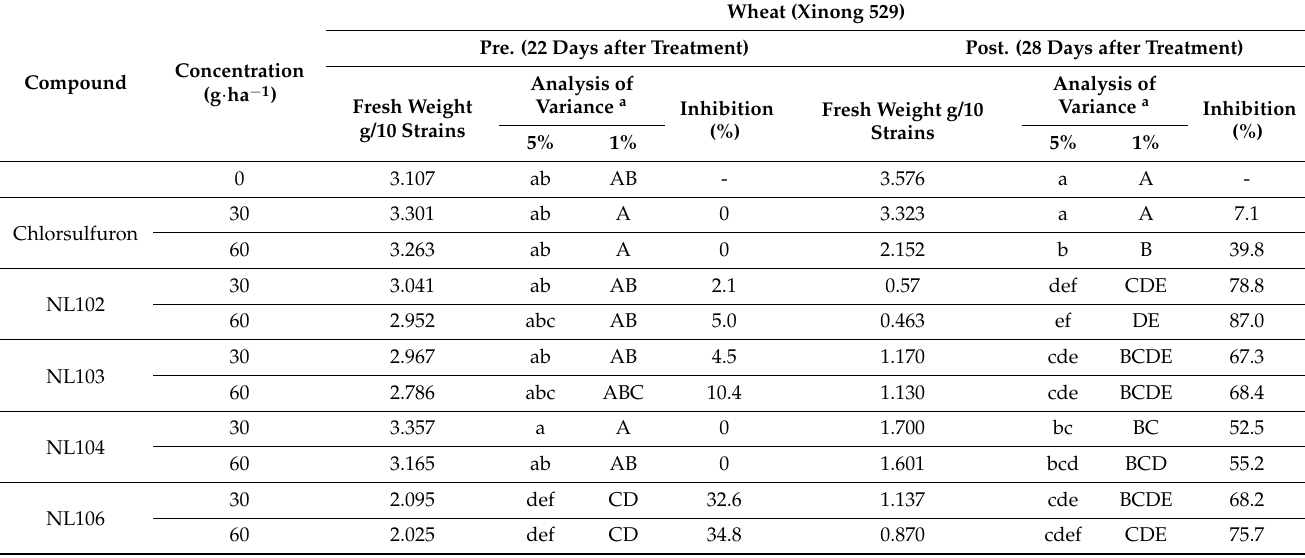
Table 4. Crop safety of target compounds on wheat.